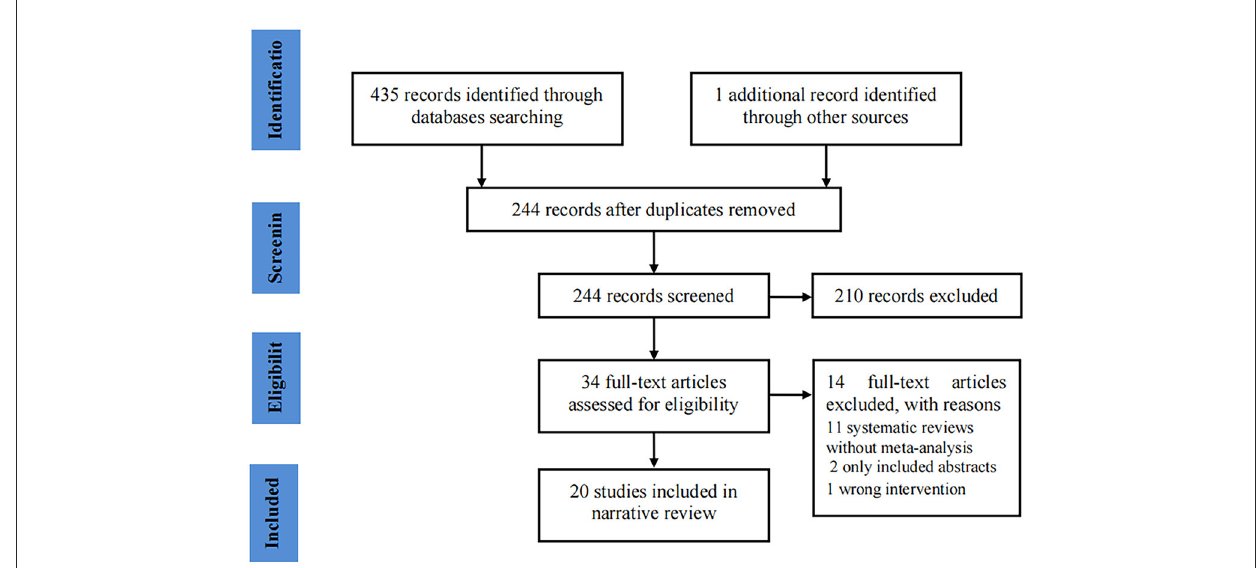
FIGURE1 PRISMA flow chart for the included studies.